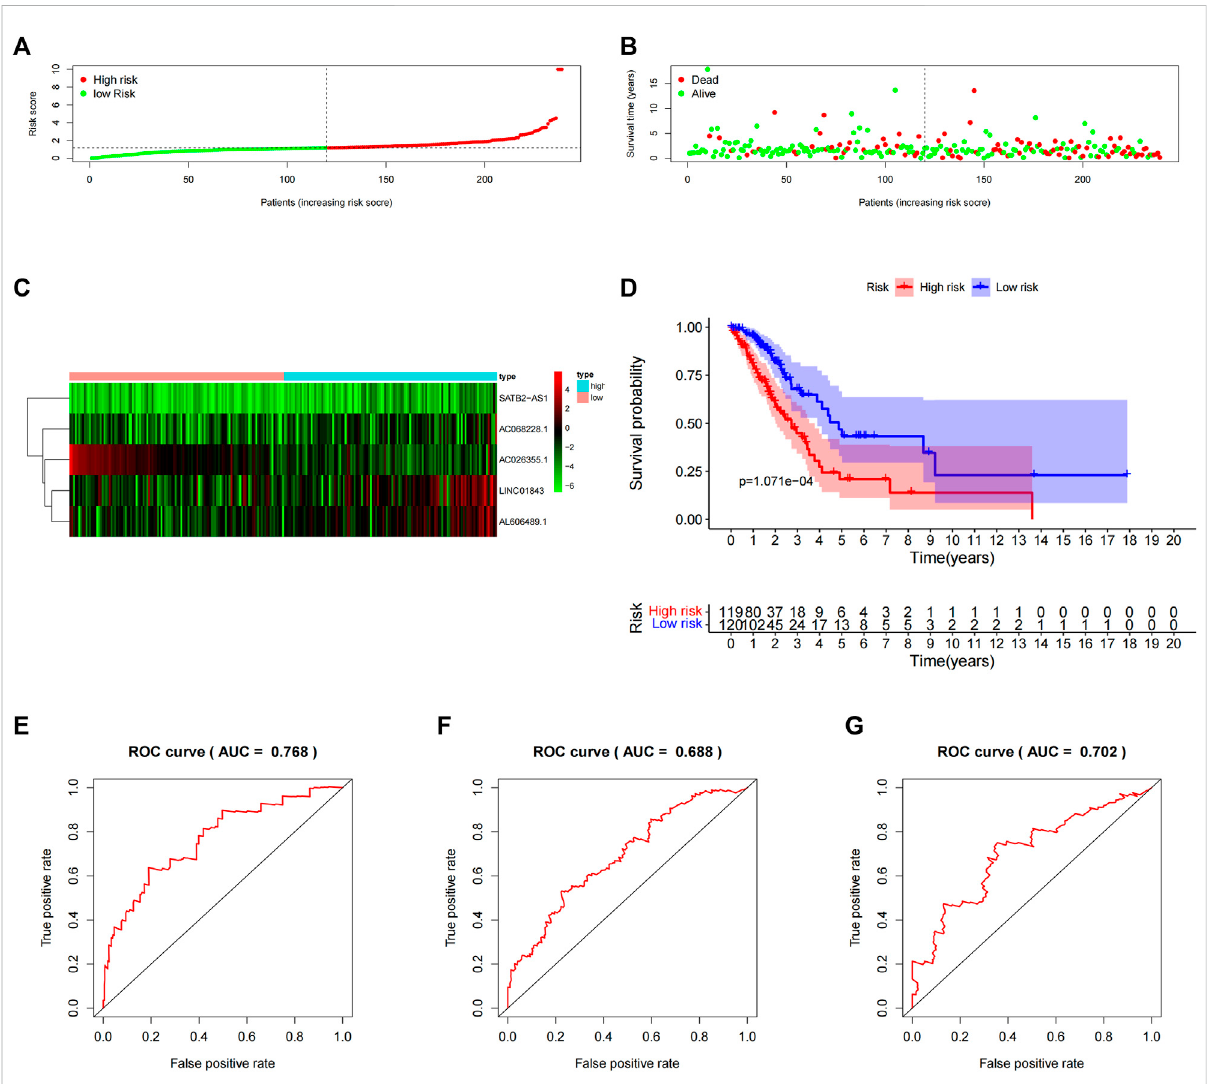
FIGURE 3 Assessmentofthe5-lncRNAsignatureforpredictingOS ofLUAD inthe “ primary dataset ” . (A) Theriskscore distributioninthe “ primarydataset ” . (B) The OS status in the “ primary dataset ” . (C) The OS-related lncRNAs expression heatmaps of the 5-lncRNA signature in the “ primary dataset ” . (D) Kaplan – Meier curves comparing OS between the high-risk groups ( n = 119) and low-risk groups ( n = 120) in the “ primary dataset ” . Blue- and red- shadedsectionsindicatethecon fi denceintervalsforsurvival.Listedbelowthecurveisthenumberofpatientsbeingatrisk. (E) Time-dependent ROCcurvebasedon5-lncRNAsignaturepredicting1 year-OSinthe “ primarydataset ” . (F) Time-dependentROCcurvebasedon5-lncRNAsignature predicting 3 years-OS in the “ primary dataset ” . (G) Time-dependent ROC curve based on 5-lncRNA signature predicting 5 years-OS in the “ primary dataset ”